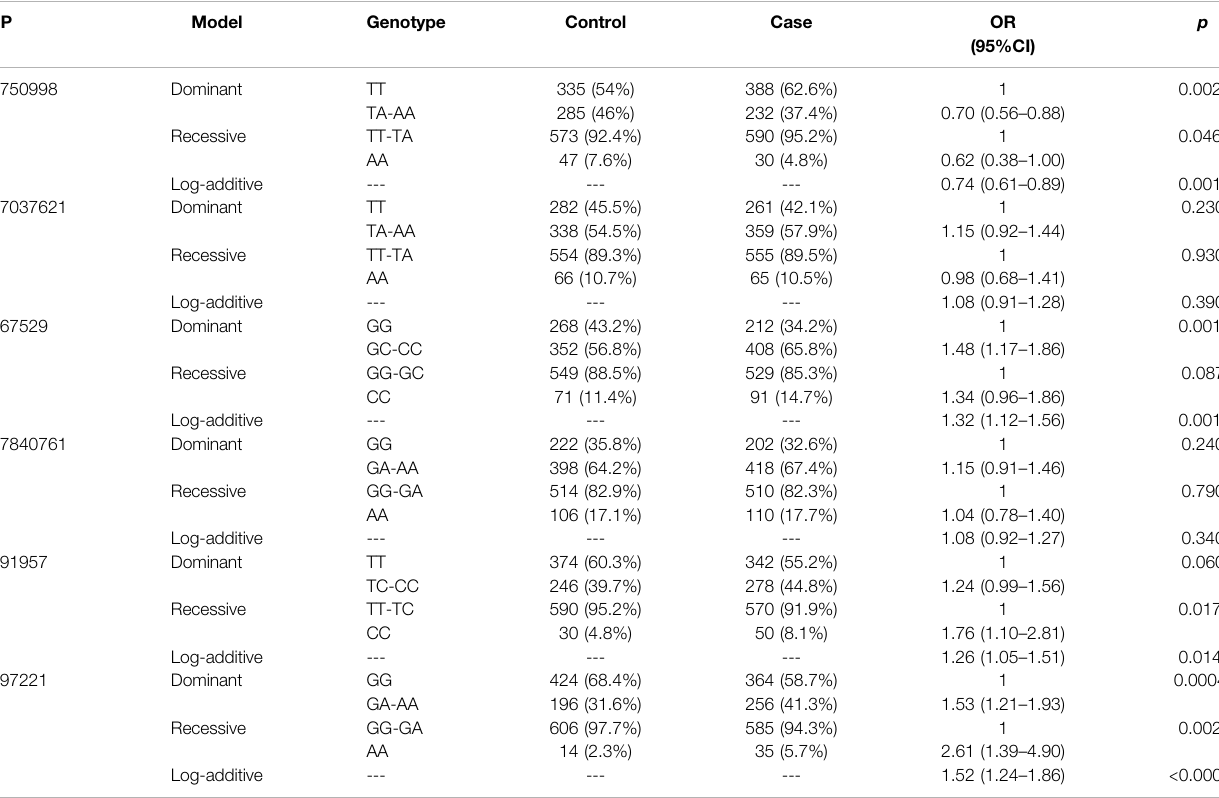
TABLE 5 | Association between SNPs and risk of lung cancer in genetic